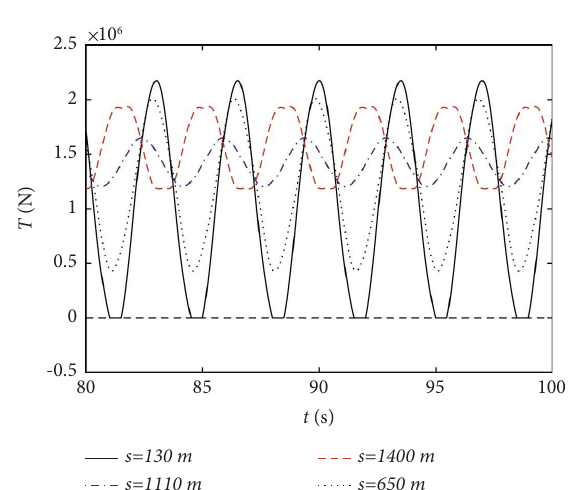
Figure 6: Time history of total tension at A